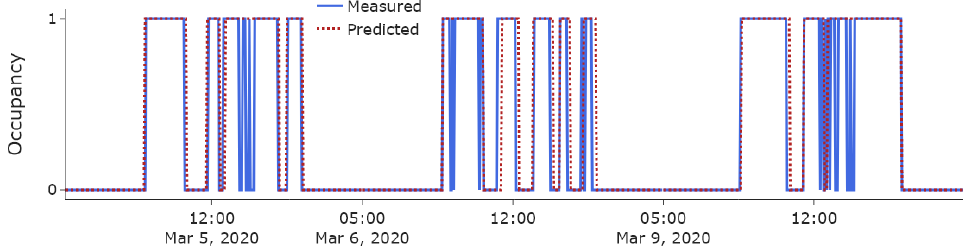
Figure 5. Three-day showcase of the source model occupancy detection performance and comparison with measured